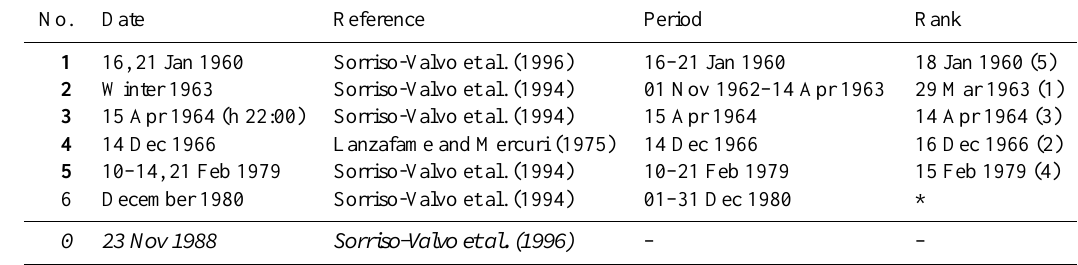
Table 2. Dates of activation of the Uncino landslide. Periods (instead of singular dates) were considered in case of uncertain timing of activation. Key = no.: identification number of the date (in bold, used for calibration); dates/periods derived from the literature; dates/periods employed for calibration or validation; references: sources of information on activation dates; rank: relative position and dates of the maxima of the mobility function during calibration. An asterisk marks the activation employed for validation. In italics, the activation date (no. 0) excluded due to hydrological constraints.